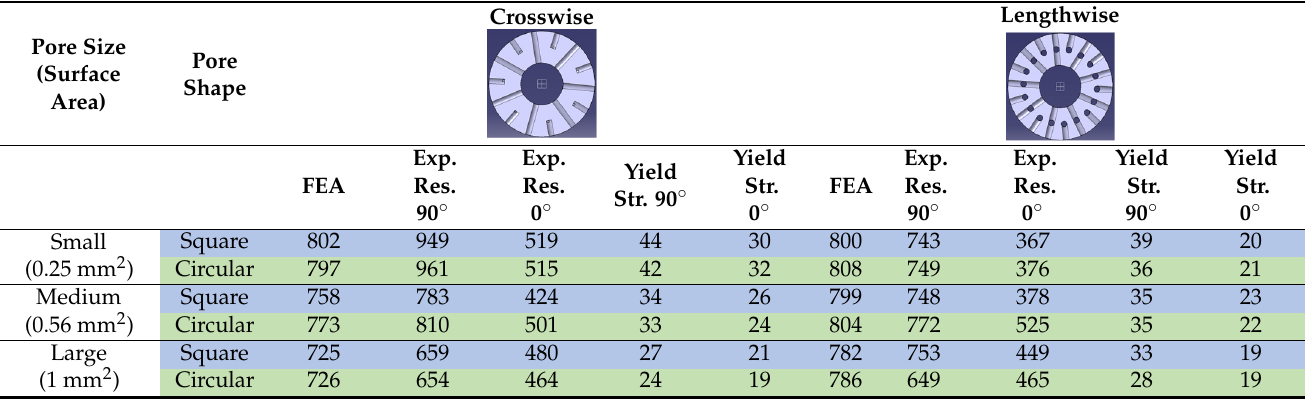
Table 3. Summary table (in MPa) of mean rigidities from FEA, mean rigidities from experimental testing, and yield strengths from experimental testing.